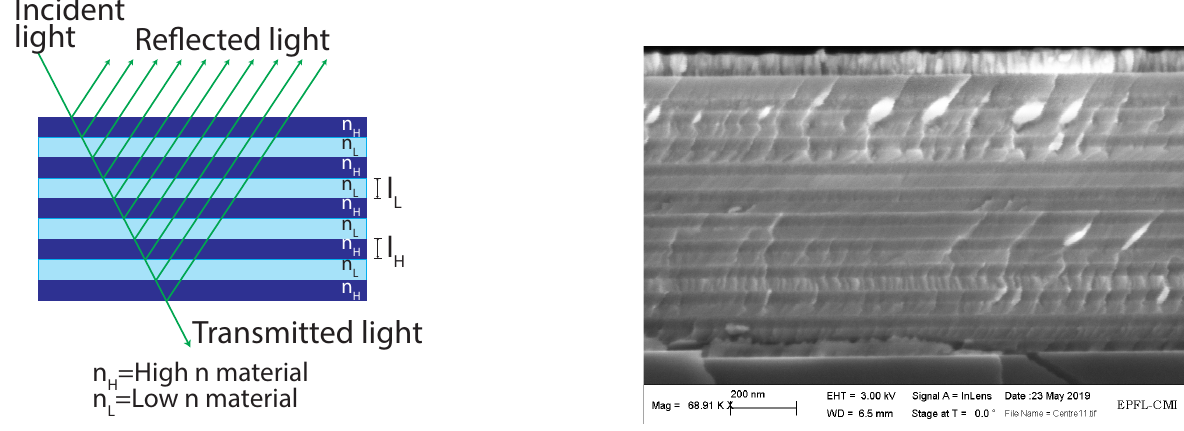
Figure 6. Distributed Bragg Reflector (DBR) scheme. Left : Schematic overview. The DBR structure is composed of a periodic alternation of layers with different index of refraction ( n H and n L ). The number of layers and the difference in refractive index between the layers have an impact on the mirror performance. Right : SEM cross-section of a DBR implemented in the EPFL’s clean rooms at the Center of MicroNanotechnology (CMI). The layer stack is clearly visible. Scale bar: 200